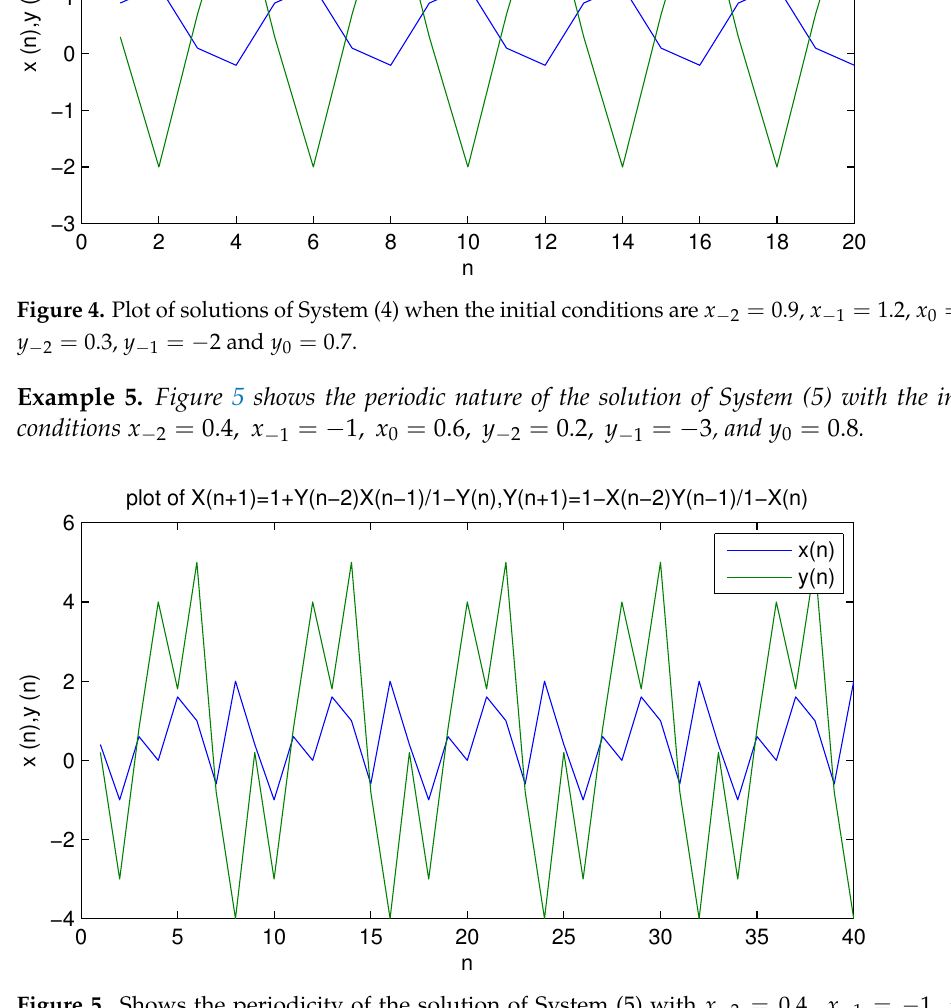
Figure 5. Shows the periodicity of the solution of System (5) with x − 2 = 0.4, x − 1 = − 1, x 0